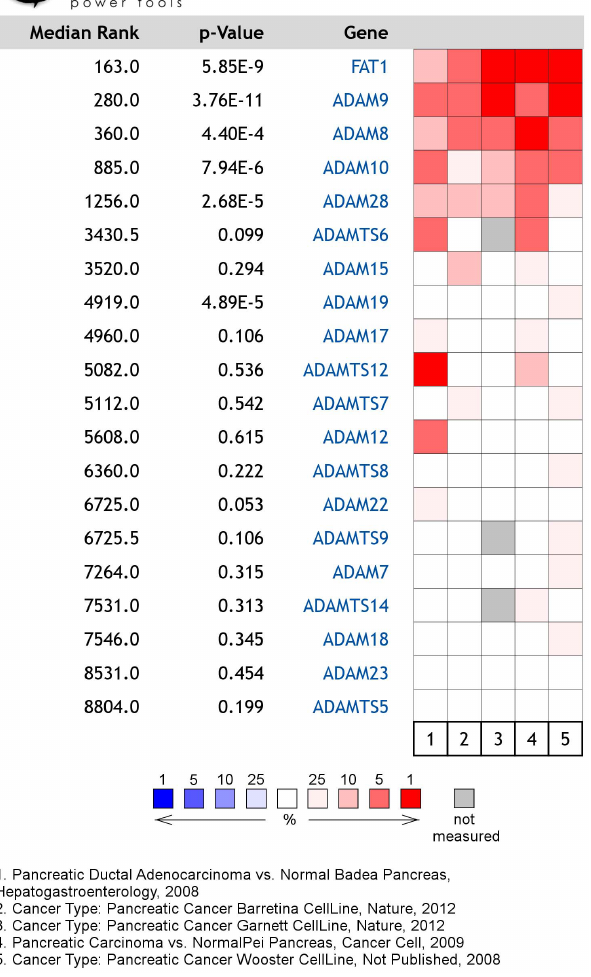
Figure 9. Fat1 and ADAM10 are overexpressed in pancreatic cancers. Oncomine analysis of five mRNA datasets indicate overex- pression of Fat1 and of its sheddase ADAM10 in pancreatic cancer. Copyright 2008–11 Compendia Bioscience, Inc. Oncomine (Compendia Bioscience, Ann Arbor, MI) was used for analysis and visualization.